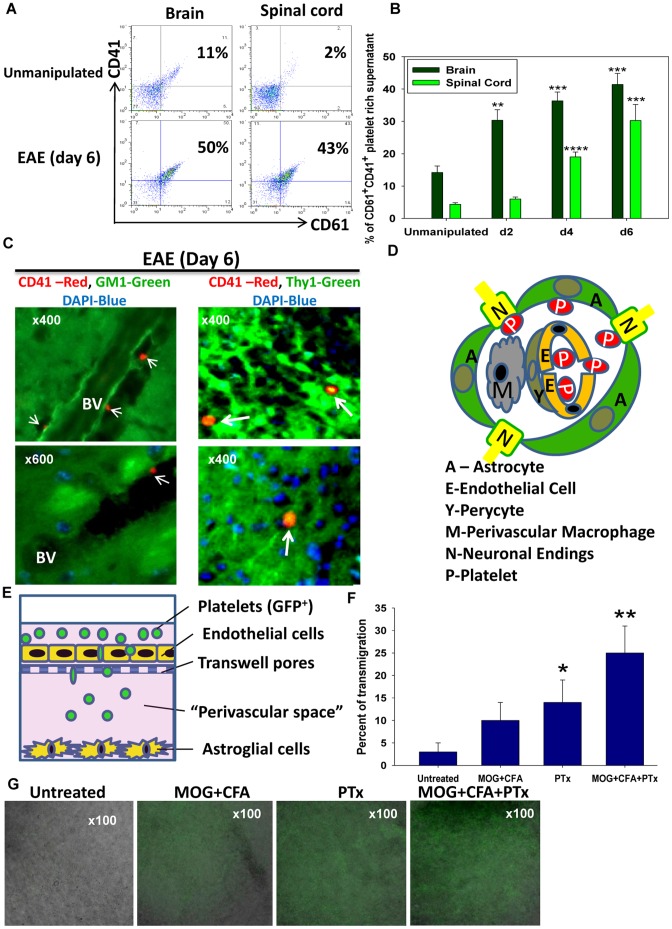
Platelets penetrate the blood-brain barrier (BBB) and accumulate in the lipid rafts-rich areas in the model of neuroinflammation.(A–C) The platelets isolated from the CNS of healthy mice or mice with EAE were analyzed by flow cytometry. The platelet-rich supernatants were prepared from the CNS homogenates, the platelets were stained for CD41 and CD61 (A) The percentages of CD41+CD61+ platelets are depicted in the upper right quadrants of the contour plots. (B) The increase of platelet numbers in the brain and spinal cord in the early stages of EAE (Mean ± S.E, five animals per group; **, p<0.01; ***, p<0.001; ****, p<0.0001; when compared to the unmanipulated mice). (C) The immunofluorescent analysis of the platelet localization within the CNS of WT B6 (C) or the Thy1-YFP reporter mice (D) with EAE on day 6. The CNS sections were double stained with CTB (green) and anti-CD41 mAbs (red) in (c, left panel) or single stained with anti-CD41 (red) in (c, right panel). The CD41+ platelets are indicated by the arrows. (D) The schematic model of platelets topographic disposition in the perivascular space and their interaction with lipid rafts on astrocytes and neurons as a result of the increased CNS blood vessel permeability. (E–F) The model of the BBB with a “perivascular space” between the monolayer of brain endothelial cells in the top chamber and the astroglial cells in the bottom chamber of the Transwell system (E). The platelets isolated from the ACTB-GFP transgenic mice were added to the top chamber together with MOG/CFA and/or PTx. The percentage of the transmigrated GFP+ platelets is shown in (F). The combined bright field (astroglial cells, grey) and fluorescent images (GFP+ platelets, green) of the bottom chambers under specified conditions are shown in (G).